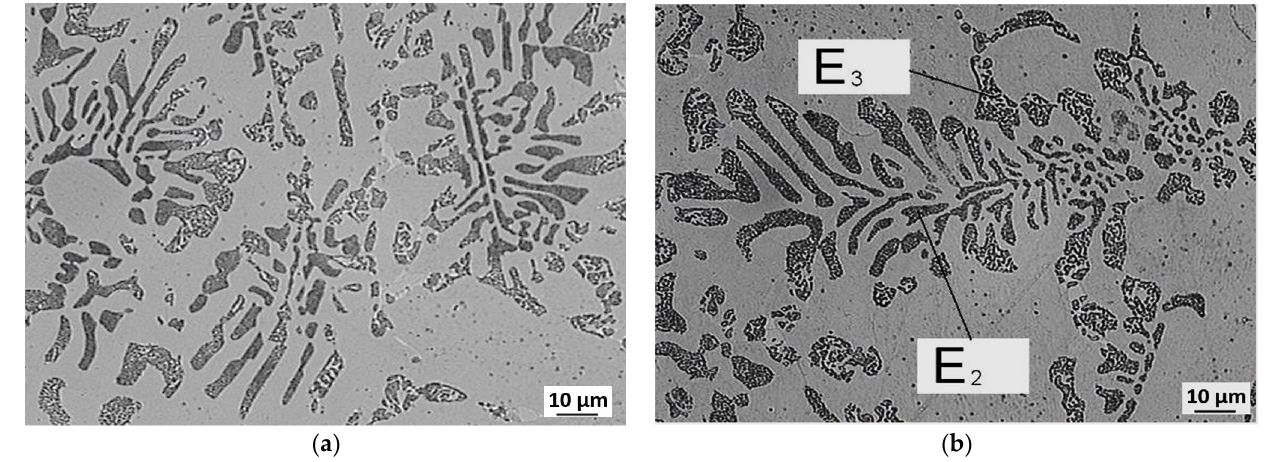
Figure 12. Comparison of ZnAl4Cu3 alloy microstructure with Cd addition, etched 0.5% HF; ( a ) after first remelting (C1 alloy); ( b ) after ninth remelting (C9 alloy).